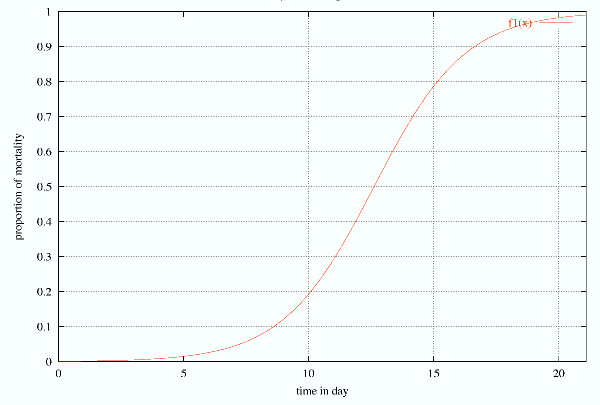
Predation percentage function of time (lag time).